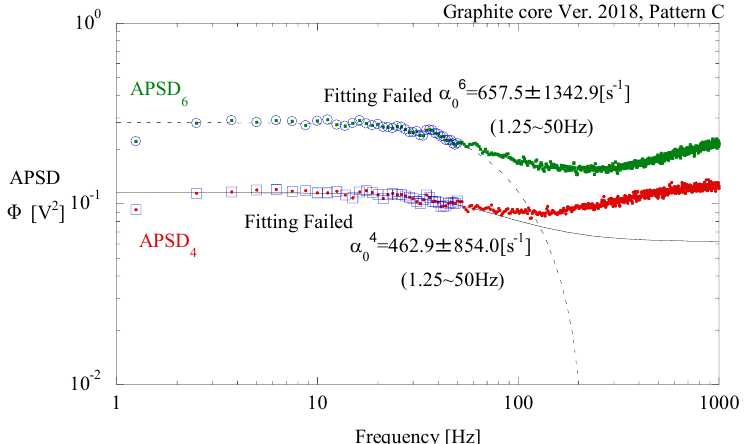
Figure 7. Auto - power spectral density from B4 and B6 in rod pattern C (subcritical state). Figure 8 shows measured cross-power spectral density between detectors B4 and B6 in rod pattern C. In rod pattern C, prompt-neutron decay constant was obtained from the cross-power spectral density between detectors B4 and B6. As the distance between the two detectors and neutron source is greatly different, the correlation component of the fuel region appears in the cross power spectral